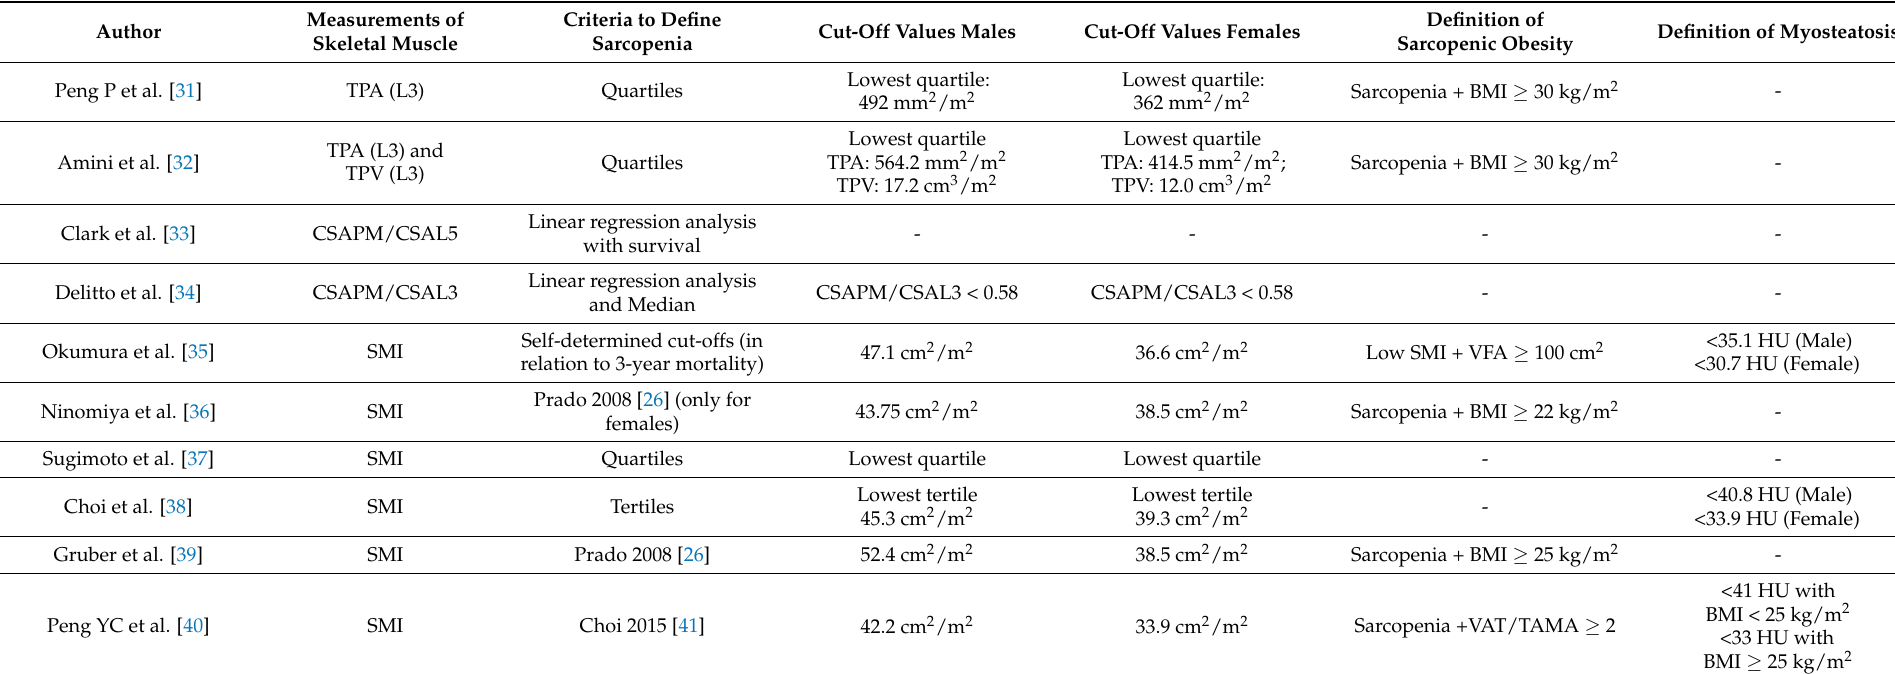
Table 1. Terminology and definitions of sarcopenia in the included